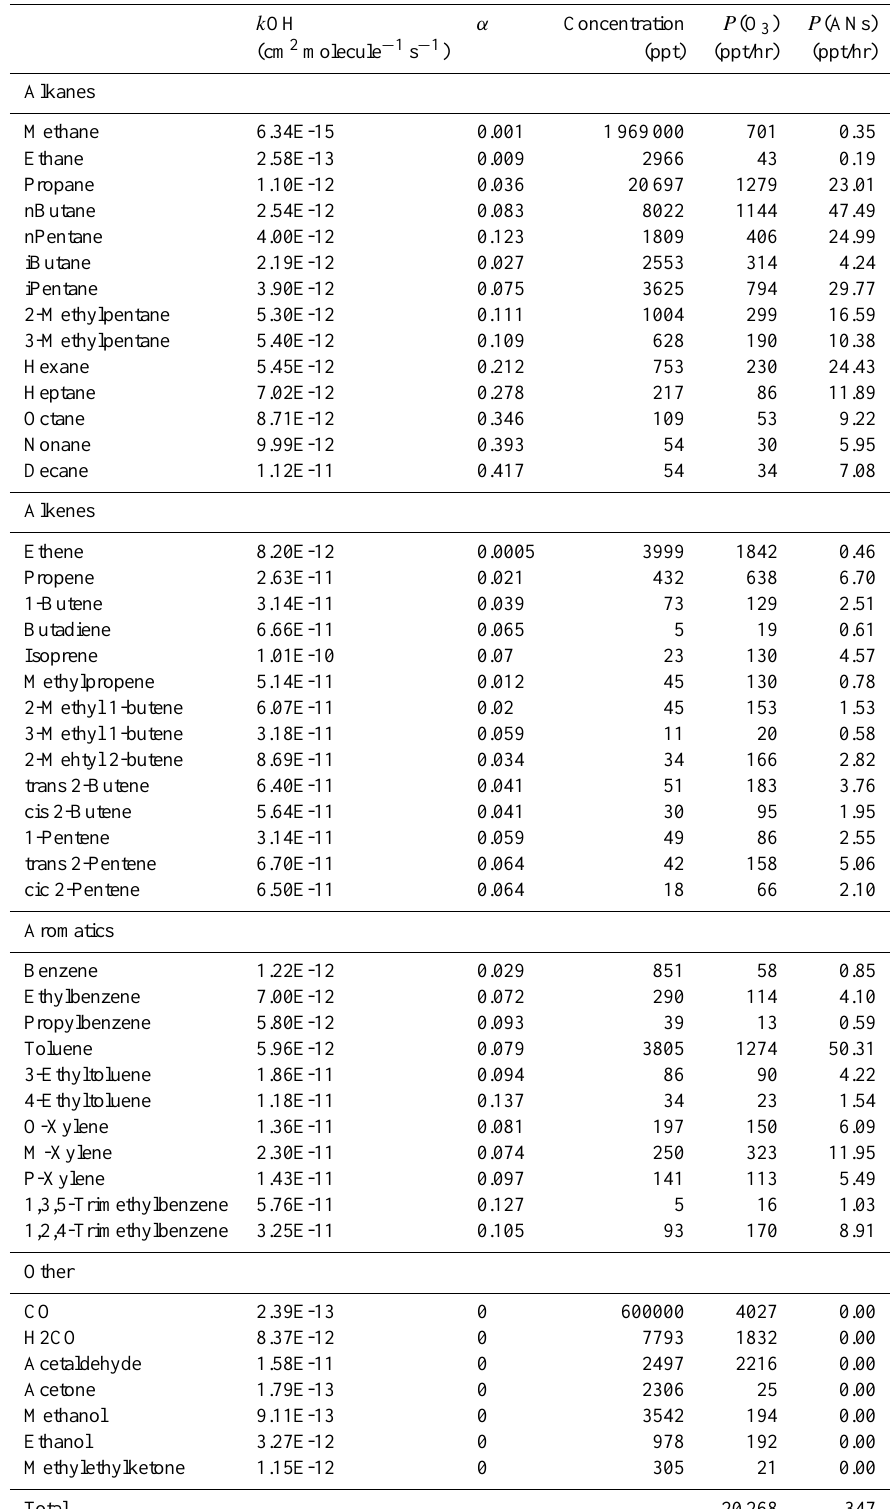
Table 1. Column 1 identifies the hydrocarbons and columns 2 and 3 show OH rate constants and nitrate branching ratios for the suite of hydrocarbons observed in Mexico City. Columns 4–6 show the median concentrations and the associated ozone and alkyl nitrate production rates